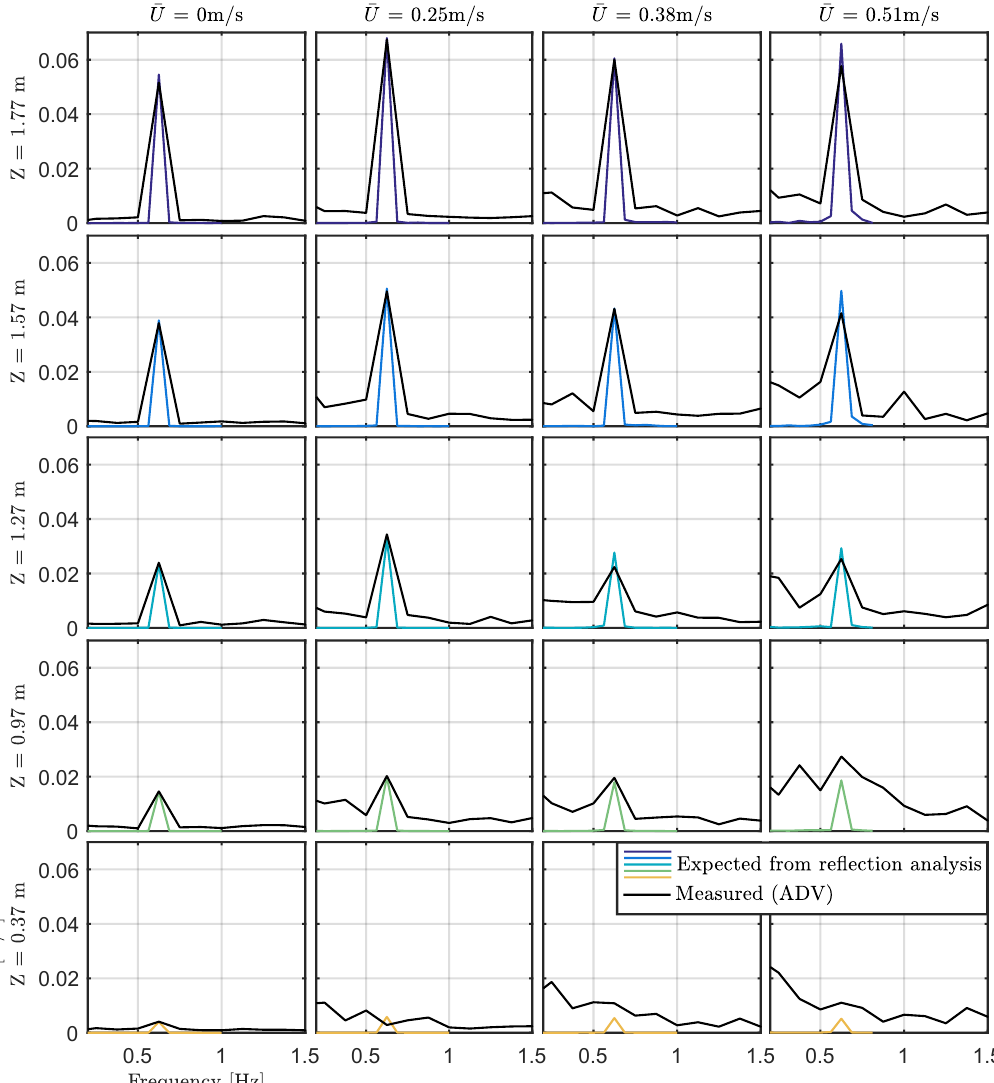
Figure 14. Measured vertical velocity spectra compared with those expected from theory. Shown for regular wave cases (Sea States 1–4, Table 3) for each of the five ADV